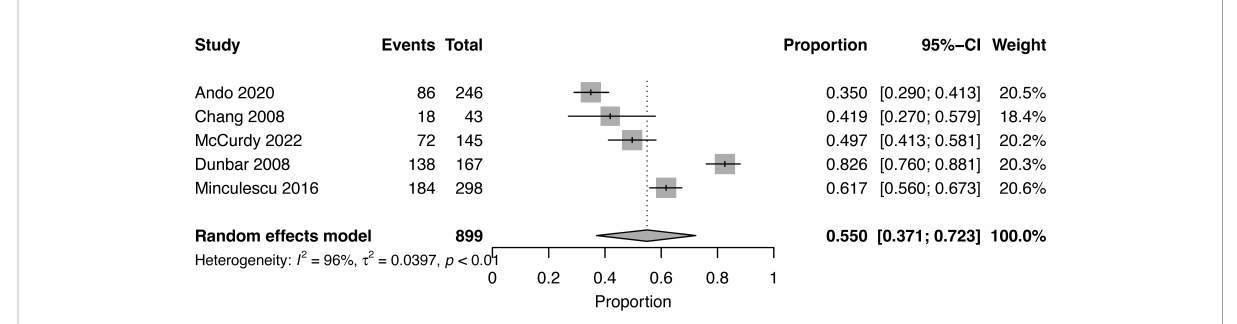
FIGURE 3 Forest plot of overall survival for low NK cells reconstitution after allogeneic